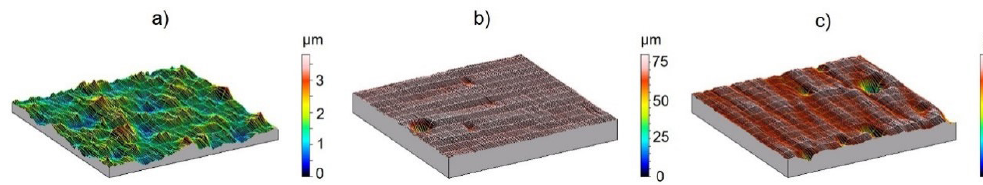
Figure 6. 3D surface profiles of geopolymer samples: (a) untreated. (b) treated with UA and (c) treated with